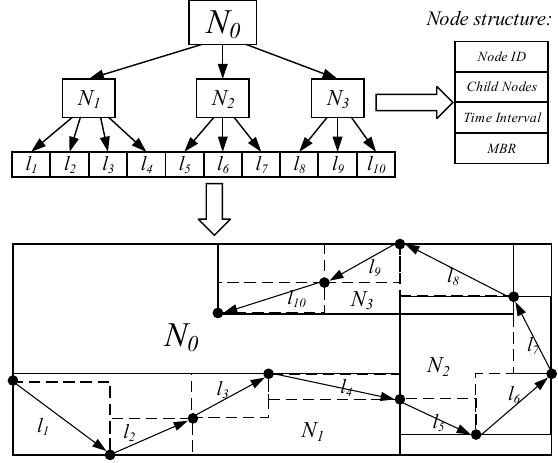
Figure 6. Example of E3DR-tree.